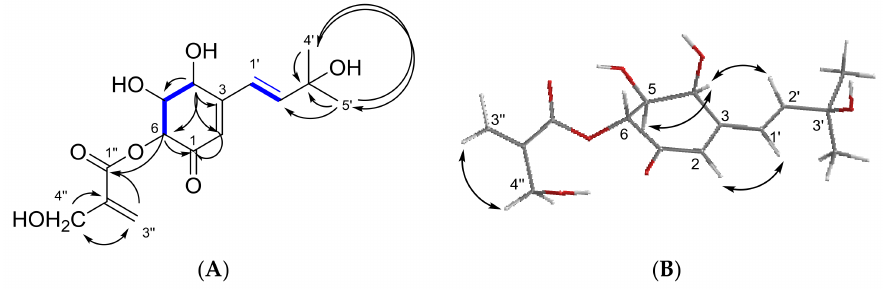
Figure 4. ( A ) COSY (in blue boldface), HMBC (black arrows) and ( B ) ROESY (black arrows) of 3